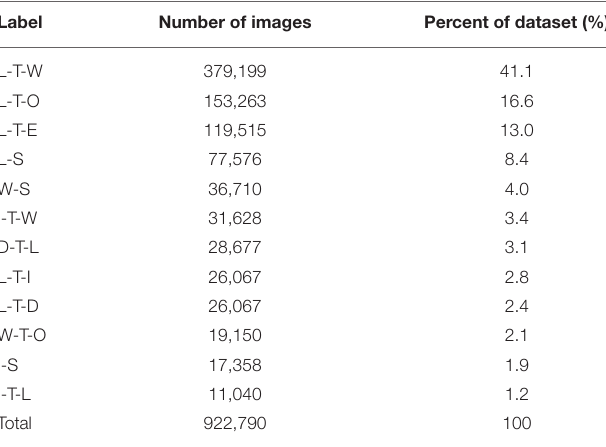
TABLE 4 | The class distributions in the ExoNet database, the images of which were annotated using a hierarchical labeling architecture. Label